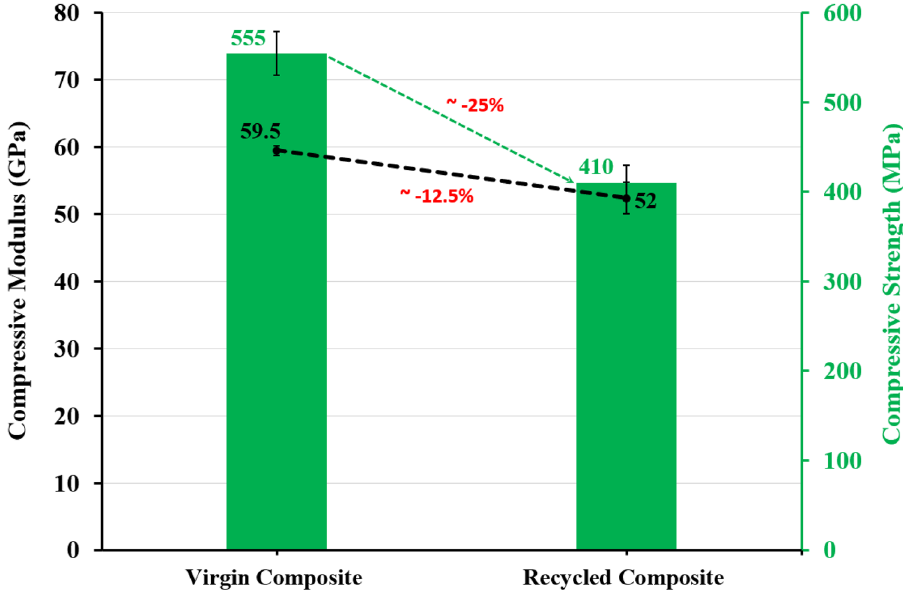
Figure 8. Compression modulus and compression strength of the virgin and recycled composites.